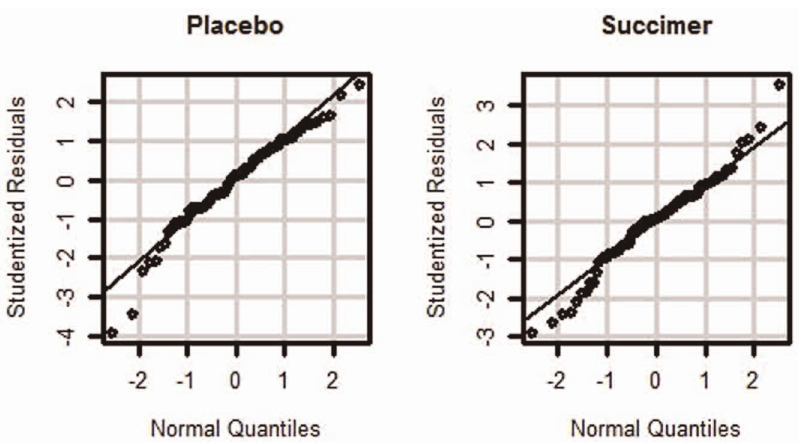
Figure 4. Normal quantile-quantile plots of studentized residuals from regressing log organic mercury in the placebo and succimer groups.